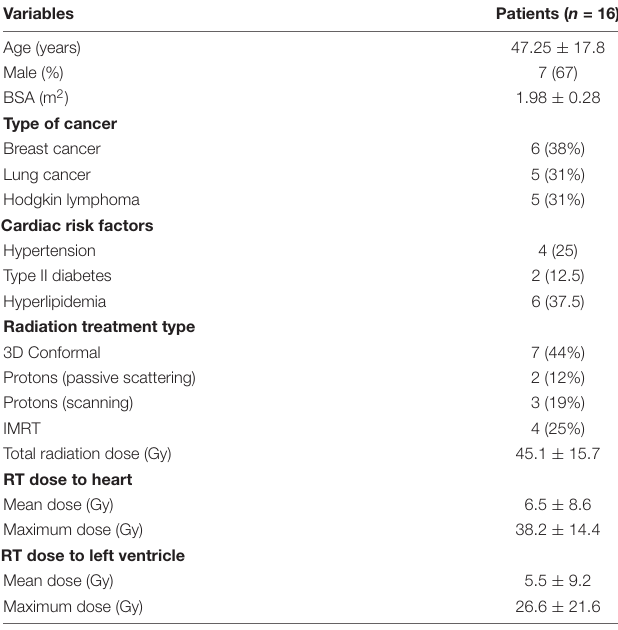
TABLE 2 | Cancer and radiation characteristics of patients. Variables